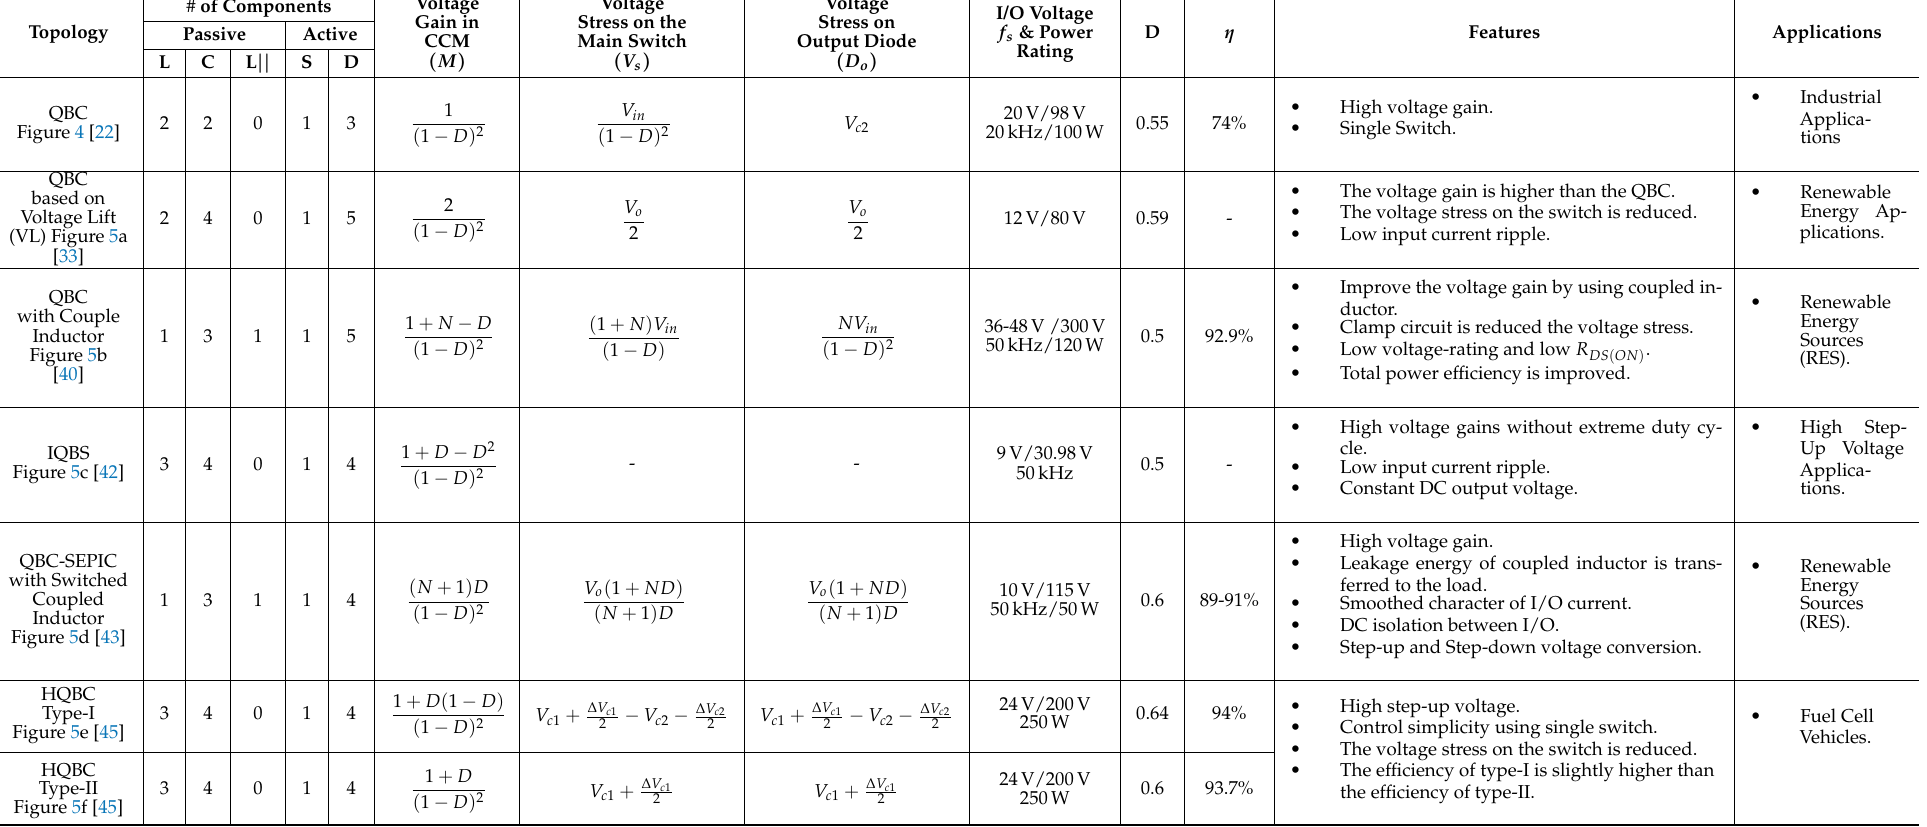
Table 2. Comparison of Quadratic Boost